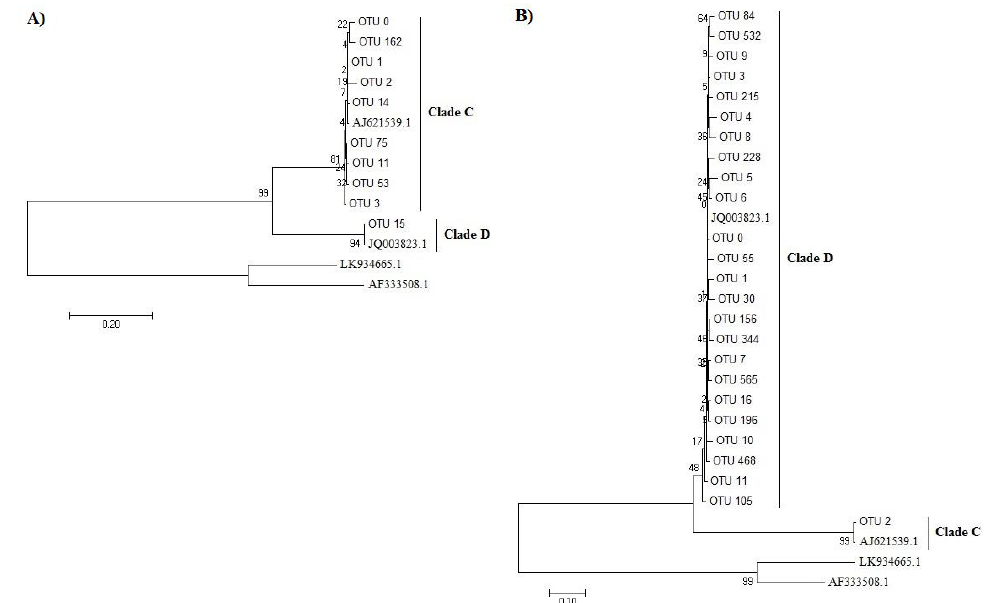
Fig. 2. Neighbor-joining tree for Symbiodinium based on ITS2 gene Sequences of Different OTUs. (a) S. trocheliophorum (b) E. ancora